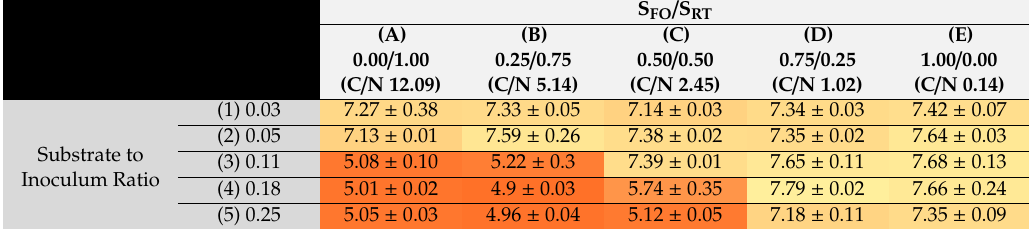
Table 5. Final pH values for each condition. The river tamarind mass is decreasing while the fish o ff al mass is increasing, from left to right in the table. The substrate to inoculum ratio is increasing from top to bottom. (NmL / gFM). ( n = 3 ±